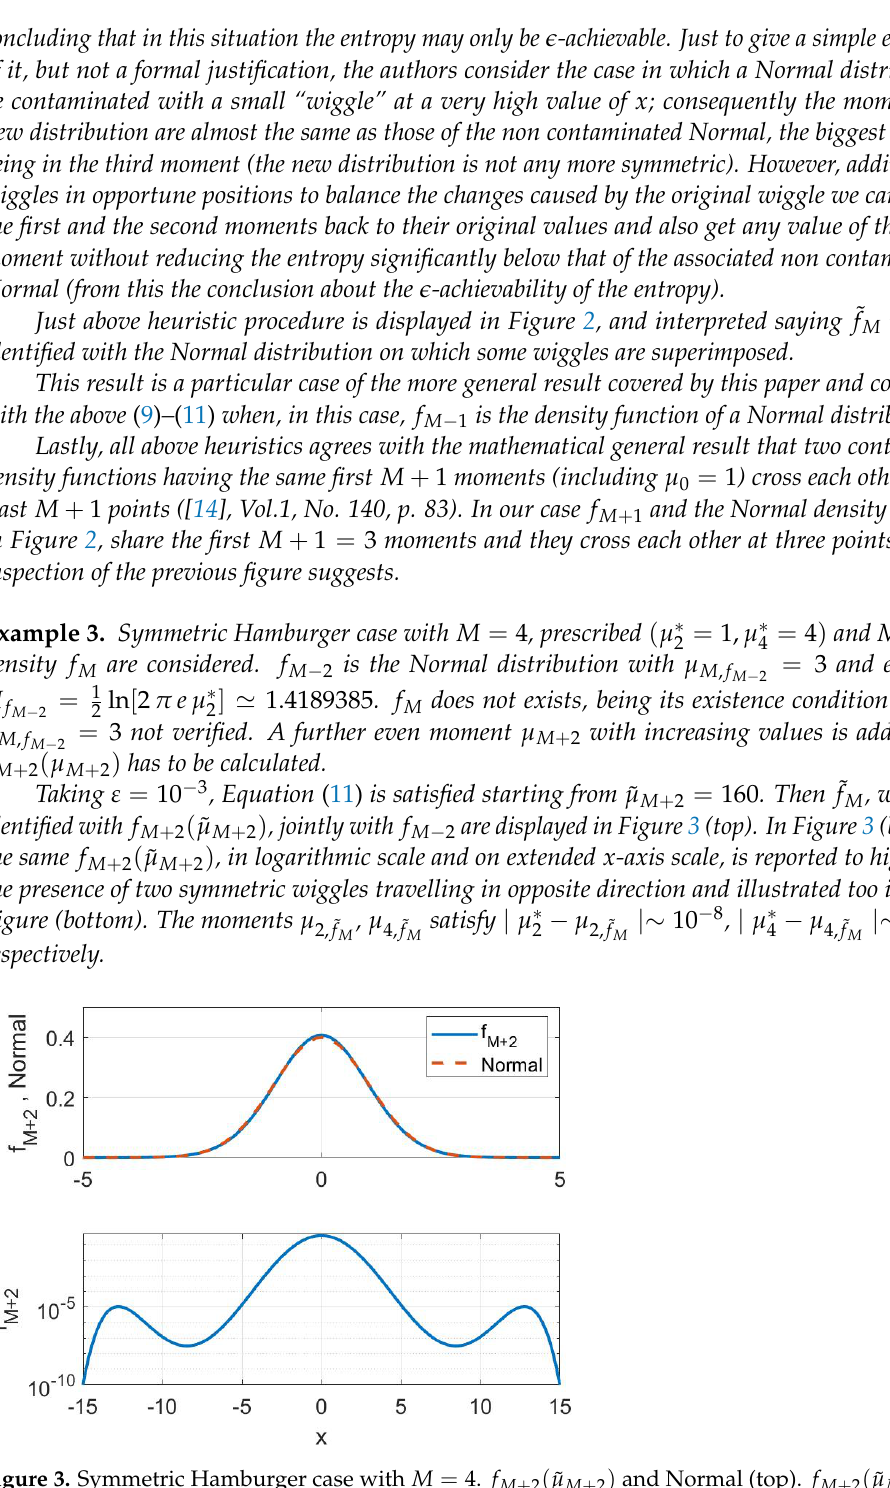
Figure 3. Symmetric Hamburger case with M = 4. f M + 2 ( ˜ µ M + 2 ) and Normal (top). f M + 2 ( ˜ µ M + 2 ) in logarithmic scale